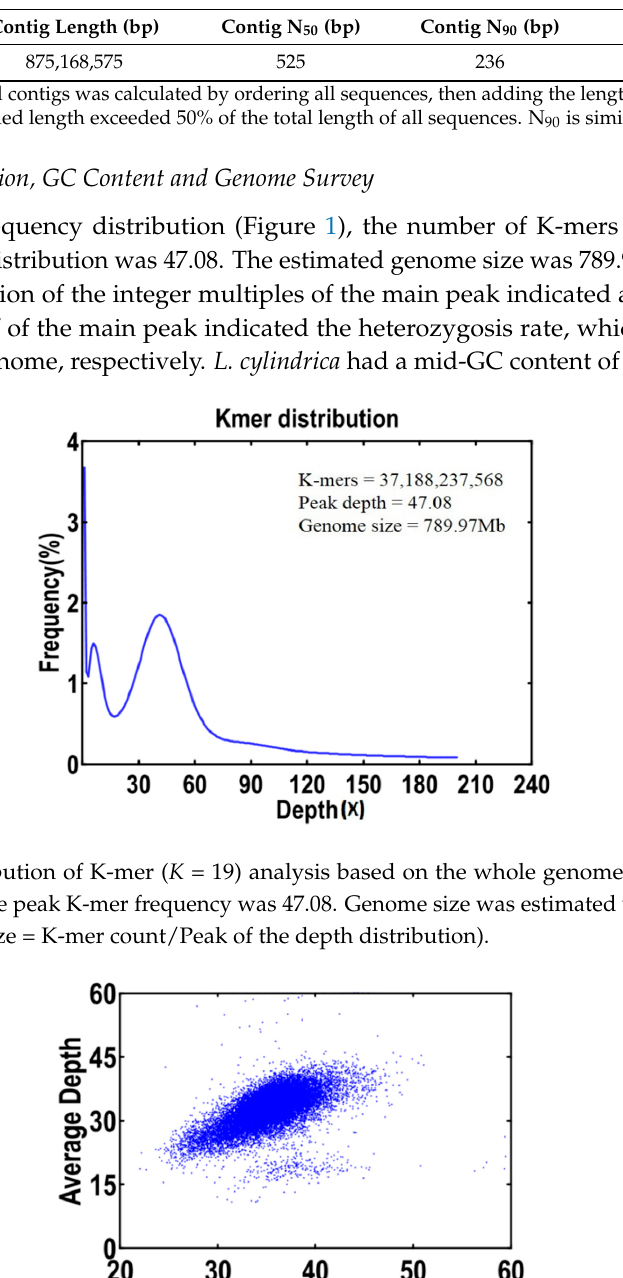
Table 2. Statistics of the Luffa cylindrica L. genome assembly.